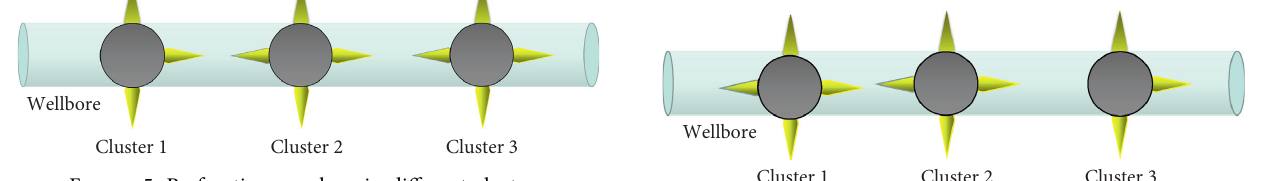
Figure 5: Perforation numbers in different clusters.